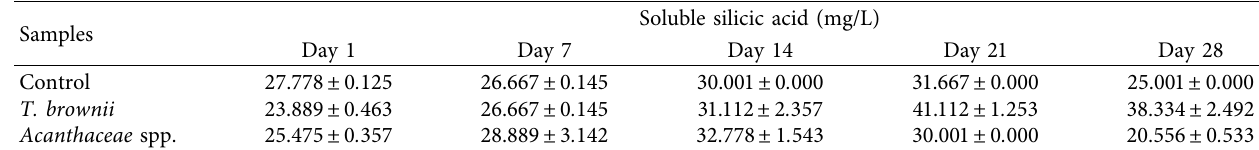
Table 9: Variation of soluble silicic acid with time in the bioslurry